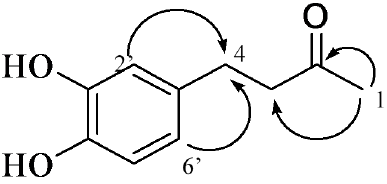
Figure 4. Important HMBC correlations of compound 17 .